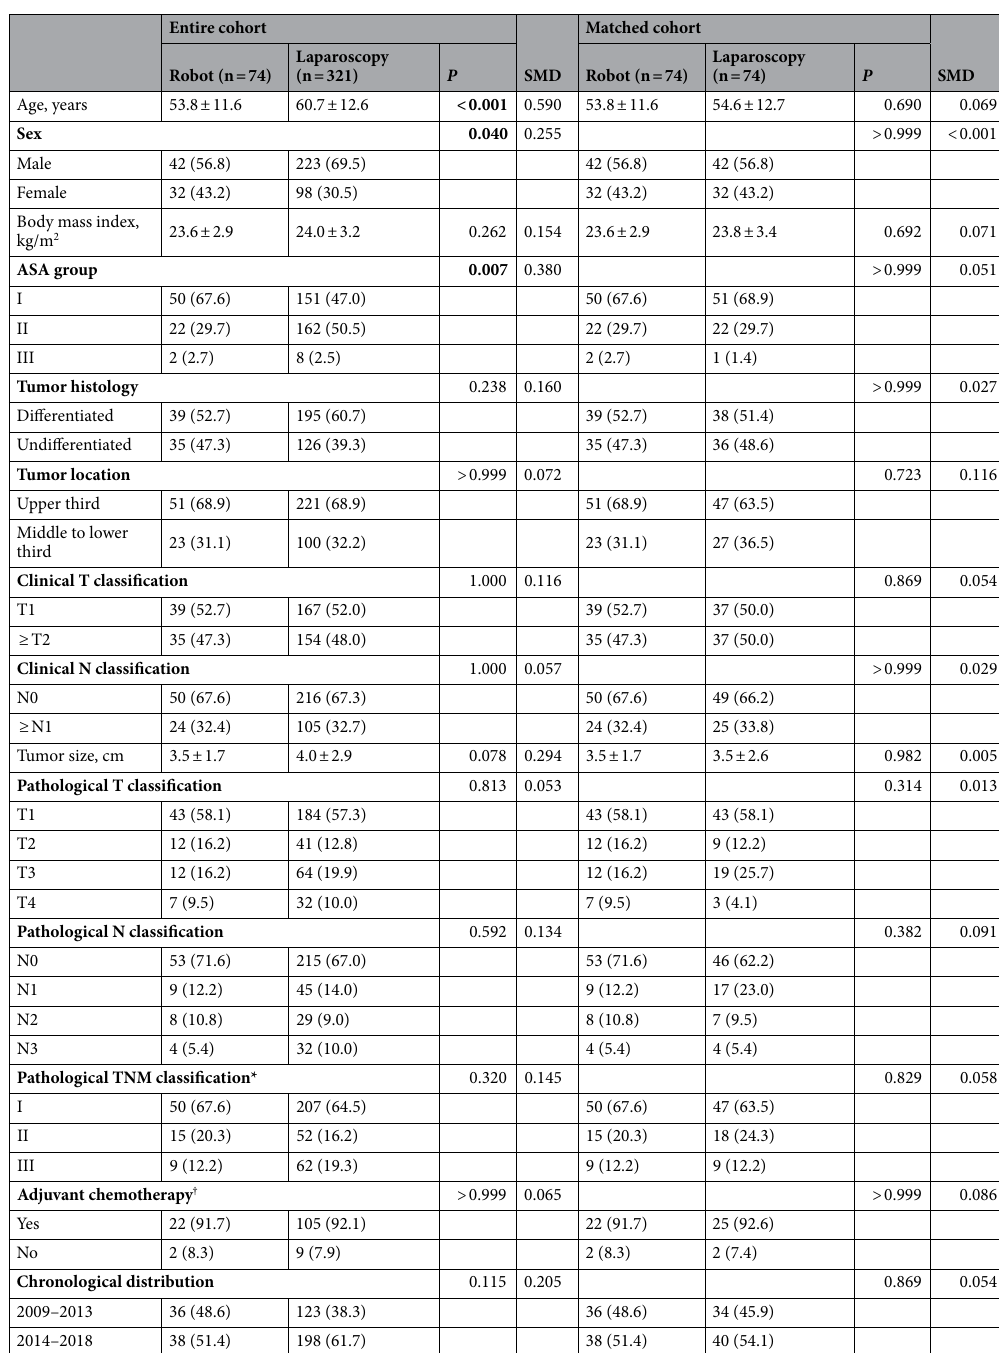
Table 1. Clinicopathologic characteristics before and after propensity score matching. Statistically significant values ( P < 0.05) are given in bold. Data are expressed as mean ± standard deviations or as n (%) unless otherwise specified. SMD standardized mean difference, ASA American Society of Anaesthesiologists. *According to American Joint Committee on Cancer 8th edition. † For patients with Stage II or